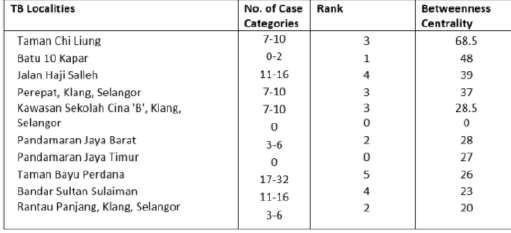
Table 3. Comparison between Rank and Betweenness